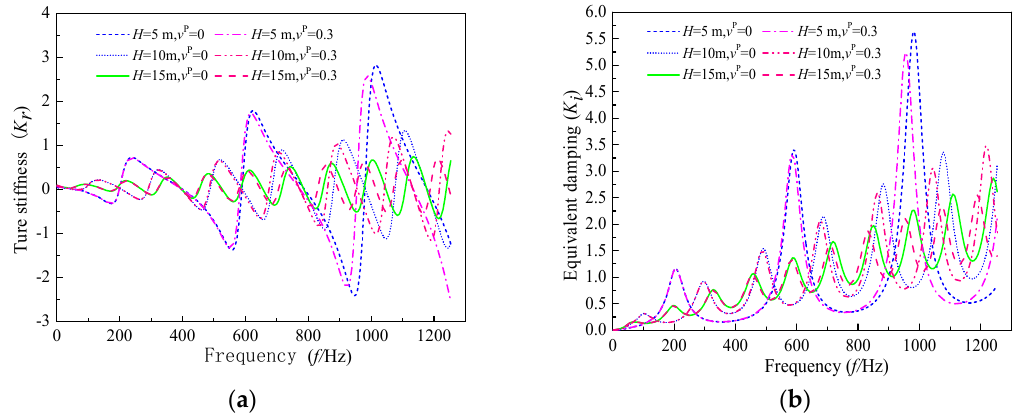
Figure 6. The effect of the pile length on the longitudinal impedance of the pile shaft: ( a ) true sti ff ness;